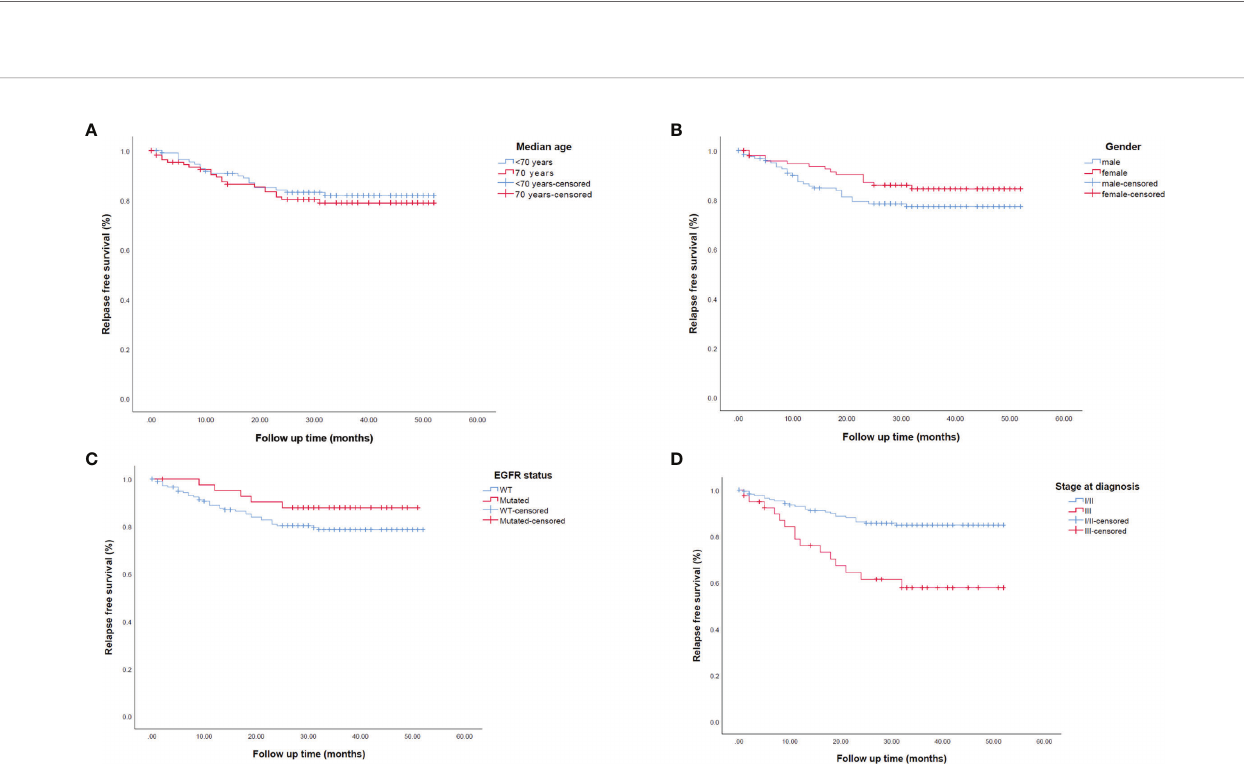
FIGURE 3 | Kaplan-Meier survival curves representing median overall survival (mOS) in early-stage resected NSCLC patients according to (A) median age, (B) gender, (C) EGFR status and (D) stage at diagnosis. EGFR, epidermal growth factor receptor; WT,